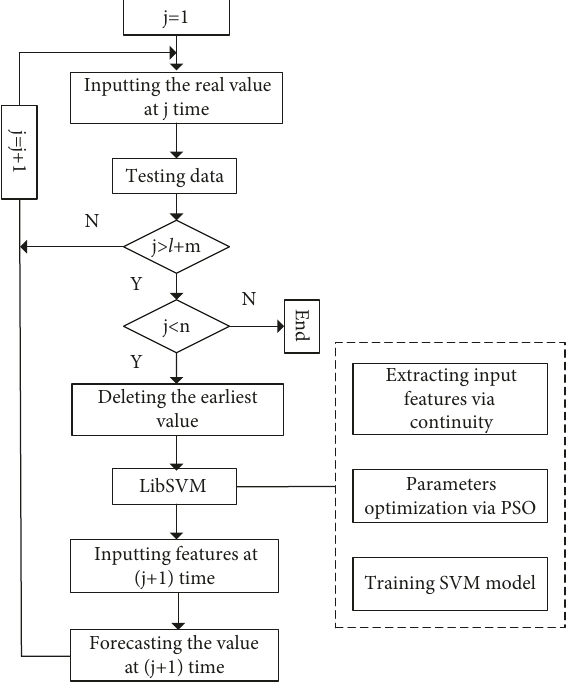
Figure 2: The process of constructing SVMPOL